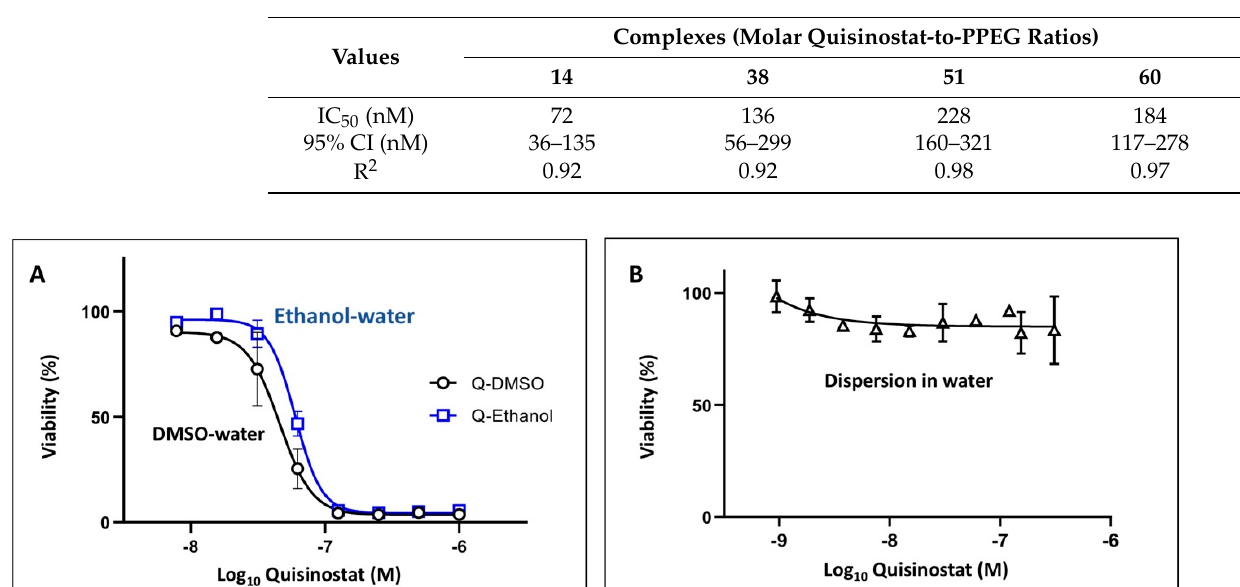
Table A4. IC 50 values of quisinostat–PPEG complexes in WM115 melanoma cells (72 h): IC 50 values calculated on the basis of quisinostat concentration.